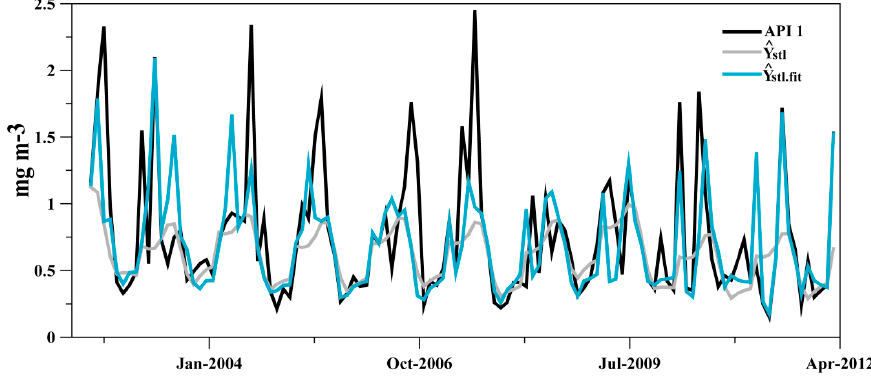
Figure 3. Time series plot of the Algal Pigment Index 1 (API 1) and the fitted models, at Station C.